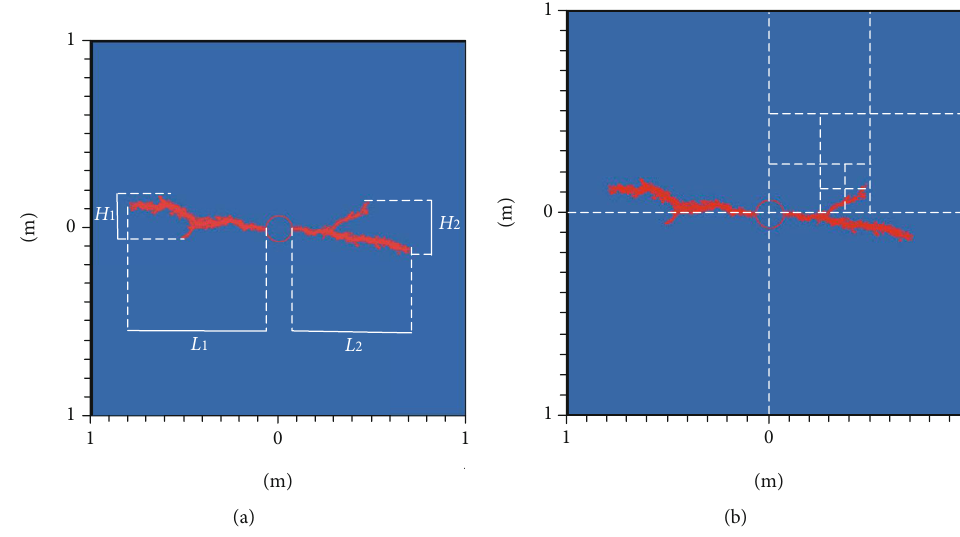
Figure 7: Extraction of fracturing